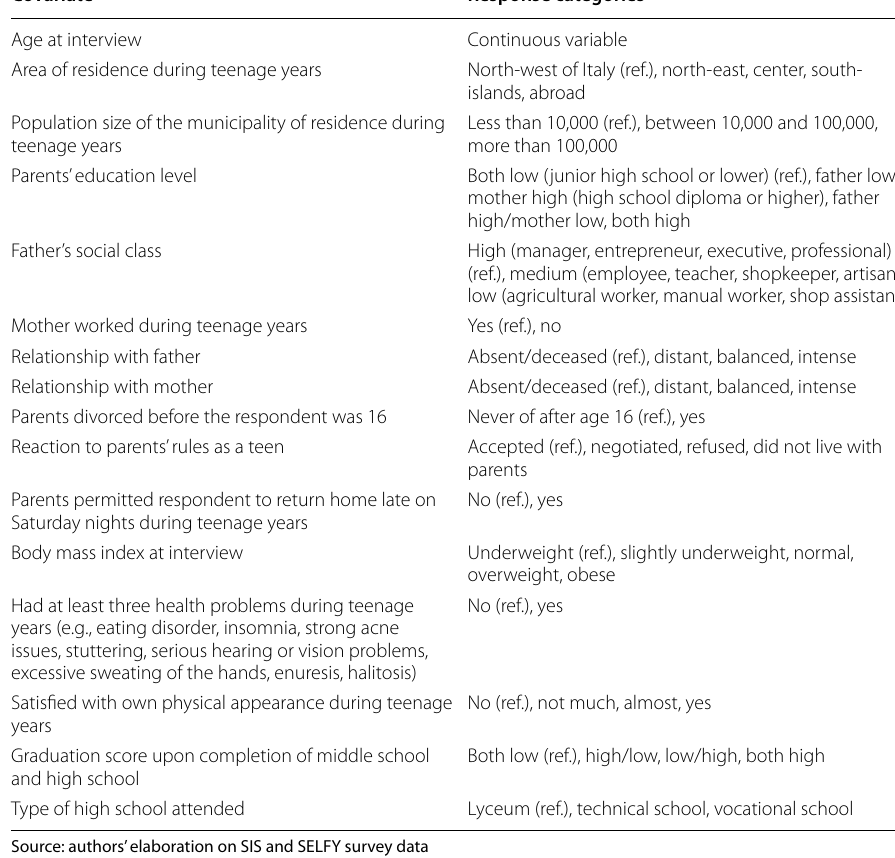
Source: authors’ elaboration on SIS and SELFY survey data